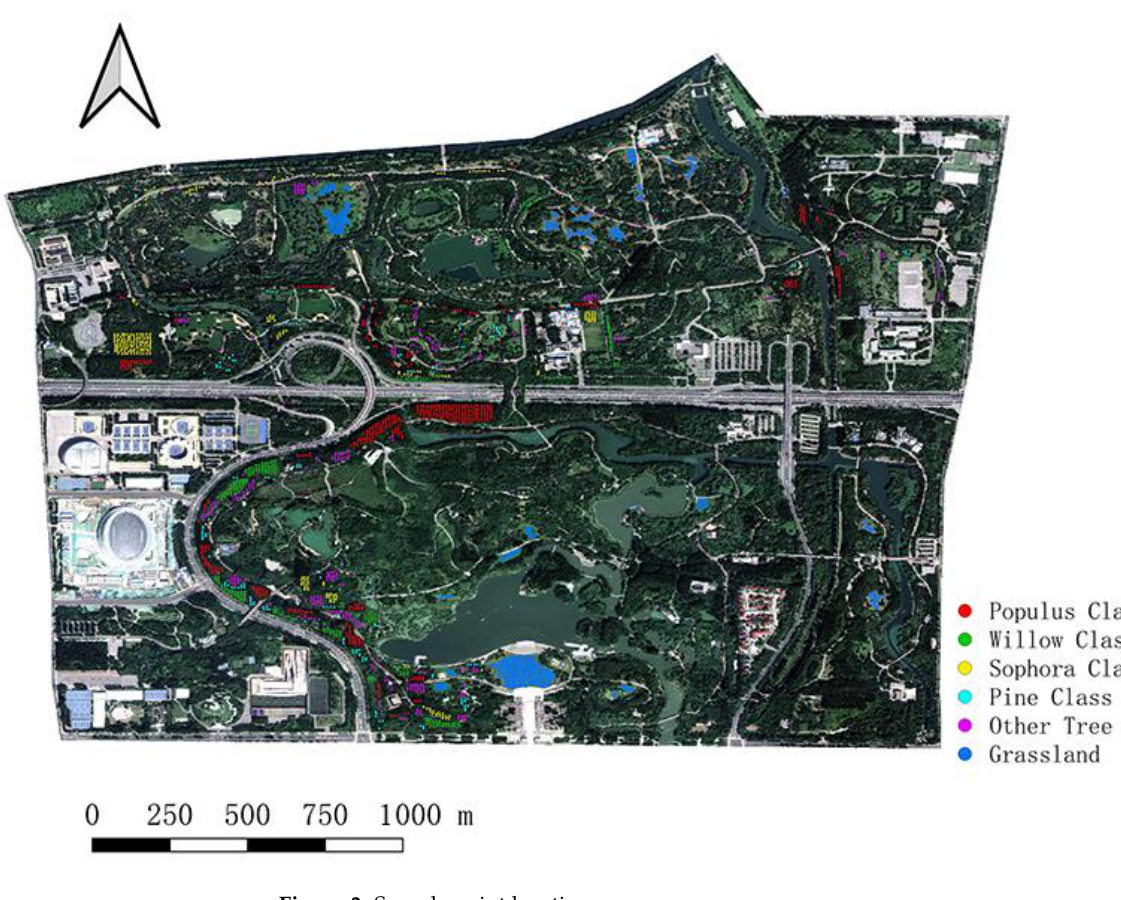
Figure 3. Sample point locations.